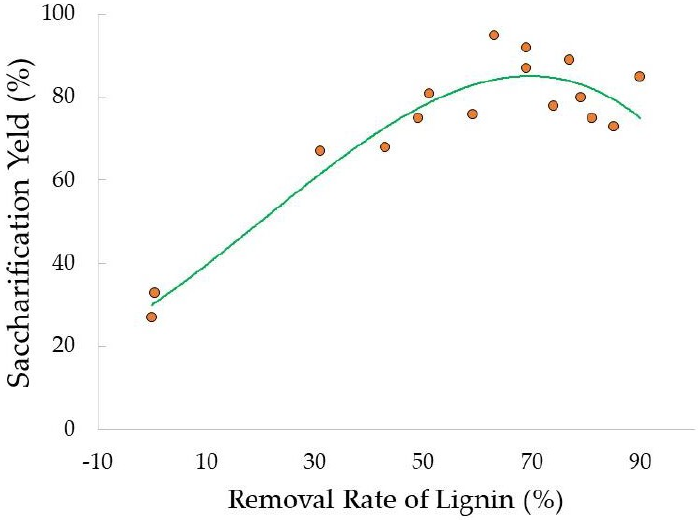
Figure 10. Influence of lignin removal on saccharification yield.